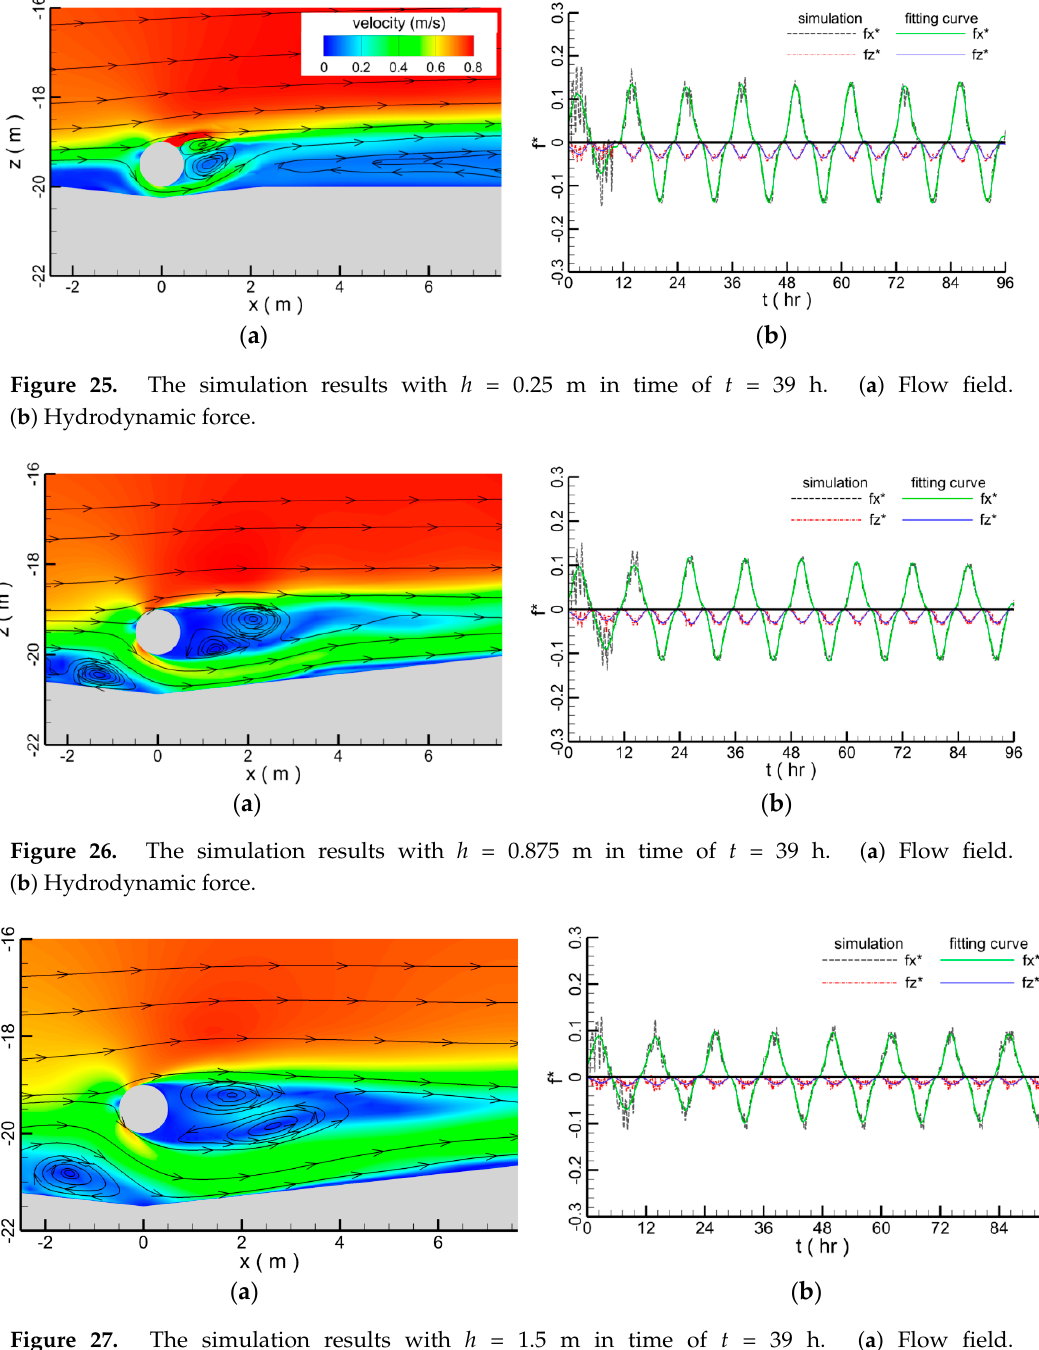
Figure 27. The simulation results with h = 1.5 m in time of t = 39 h. ( a ) Flow field. ( b ) Hydrodynamic force.